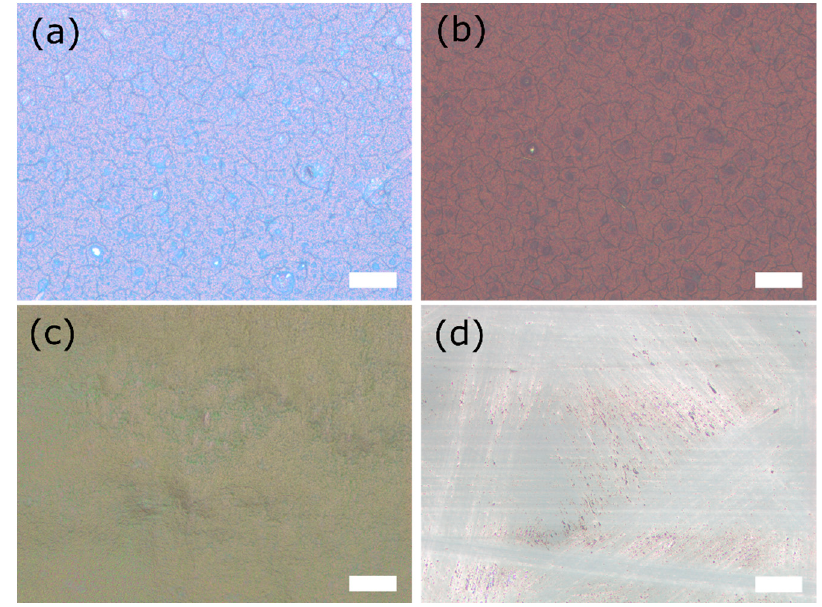
Figure 2. Reflected-light microscope images of DSSC components in 10 × magnification: ( a ) TiO 2 layer of the front electrode, pre-coated on a glass electrode by Man Solar; ( b ) With forest fruit tea dyed TiO 2 layer of the front electrode; ( c ) Gel electrolyte of sample 1, 1.5 h after coating with a box-type doctor blade on a glass slide; ( d ) Counter electrode, coated with graphite pencil. Scale-bars indicate 100 µm.